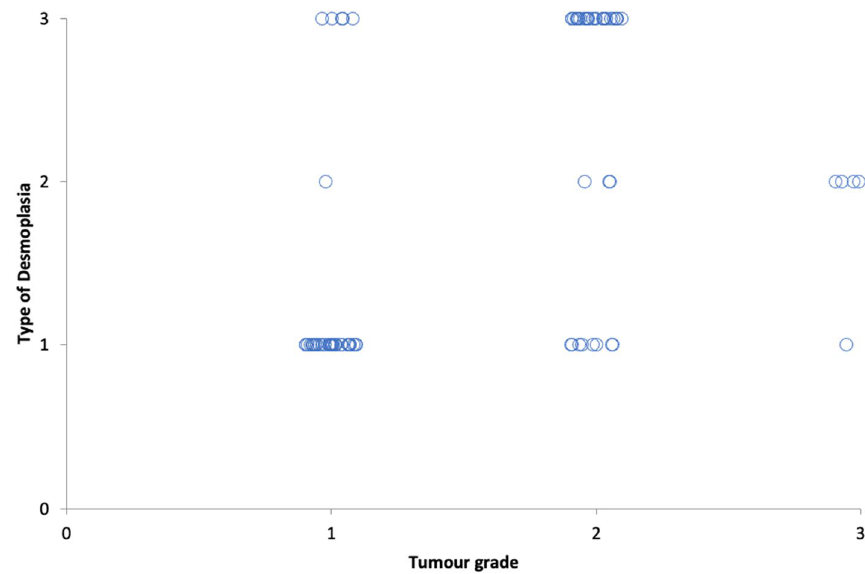
Fig. 5 Scatter plot showing correlation between tumor grade and stromal desmoplastic pattern